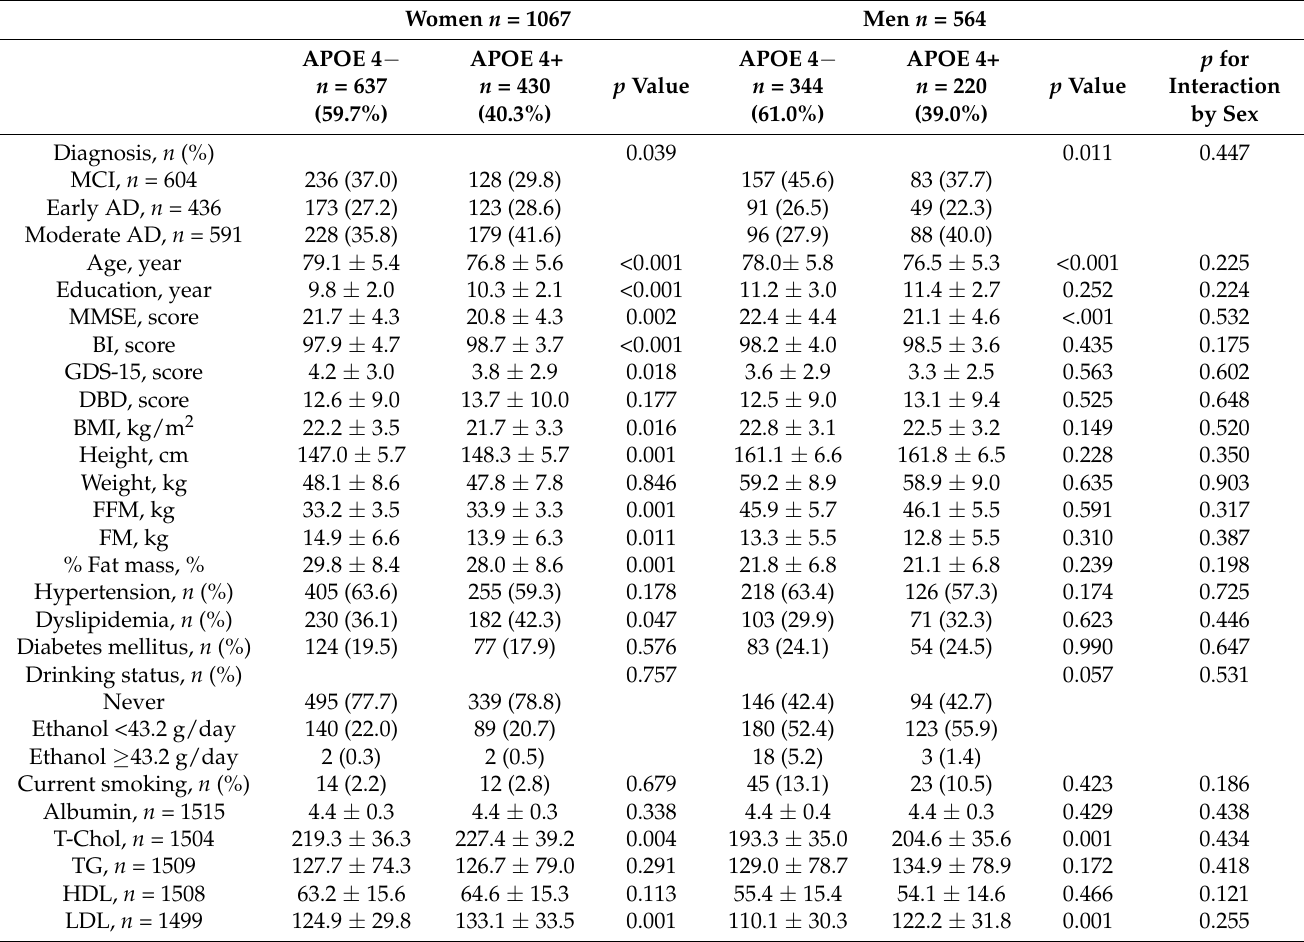
Table 1. Demographic and clinical characteristics of participants by APOE- ε 4 carrier